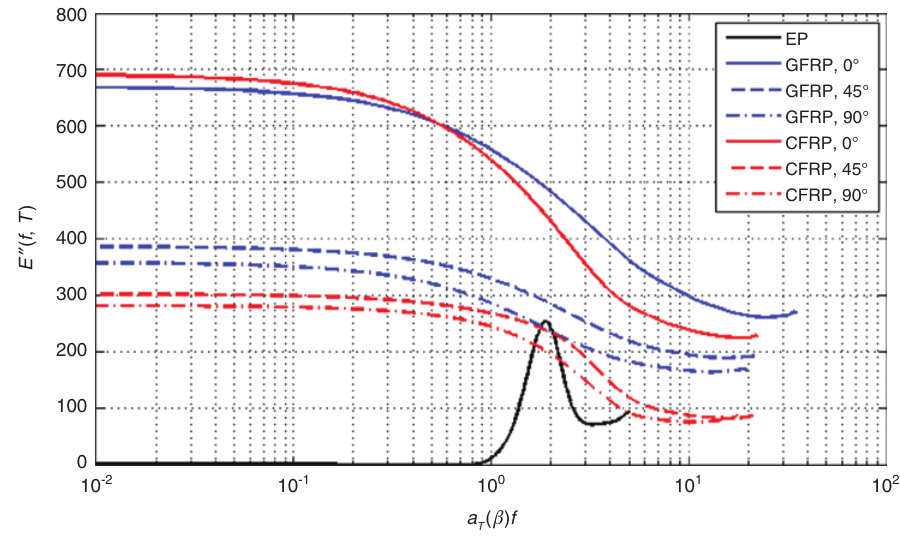
Figure 9: Master curves of the loss modulus for various materials and fibre orientation.